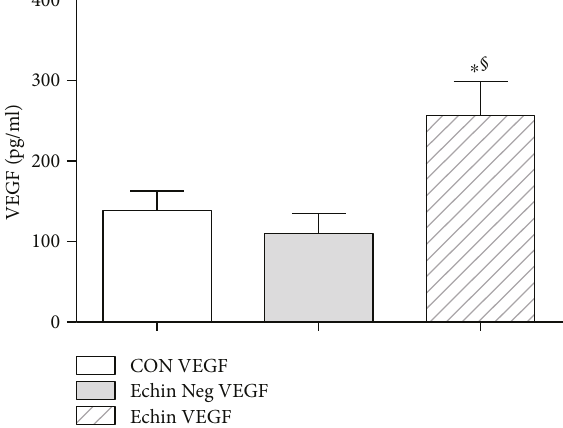
Figure 5: Serum levels of VEGF in the group of infected patients (Echin VEGF) are signi fi cantly increased ( p < 0 05 ) versus the correspondent parameters in the group of Echinococcus -negative patients (Echin Neg VEGF) and in the group of control subjects (CON VEGF). Values are expressed as mean ± SEM. ∗ p < 0 05 versus CON; § p < 0 05 versus Echin Neg, after ANOVA and Fisher PLSD